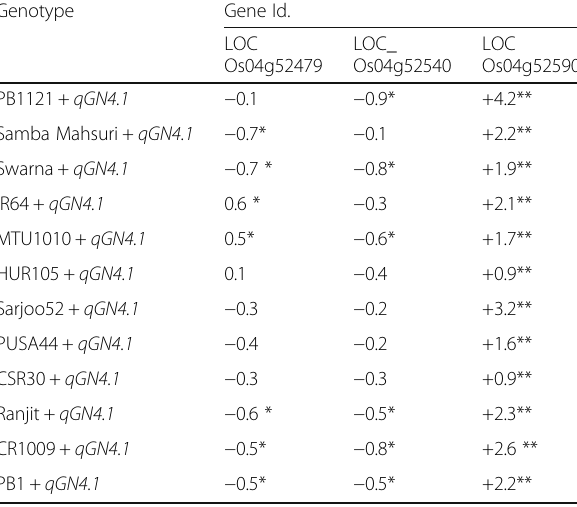
Table 3 Fold Change in the Expression Level of Three Genes Located in the qGN4.1 QTL Interval in the Panicle Primordia of Twelve QTL Introgression Lines in Comparison to the Respective Recipient Parents as Detrmined Using qRT-PCR